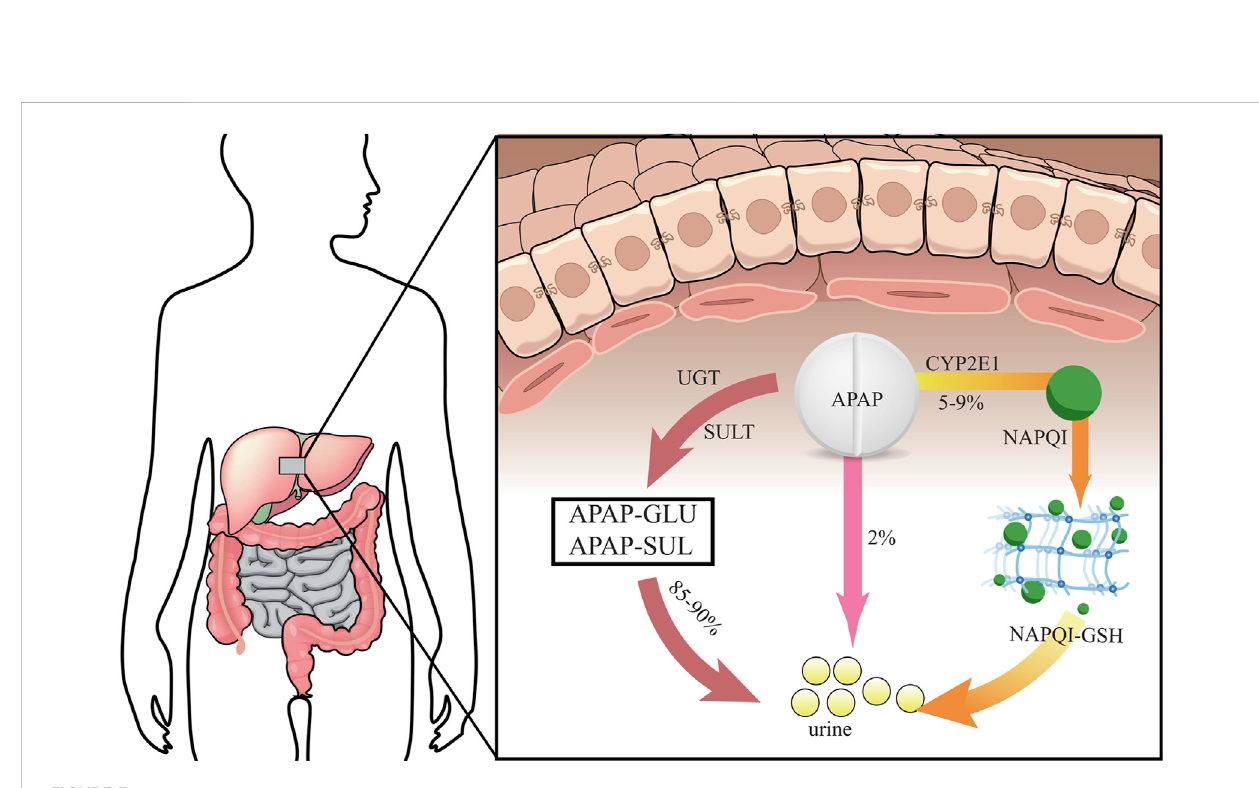
FIGURE 3 Human APAP is metabolized and detoxi fi ed in liver tissue via different processes before urine